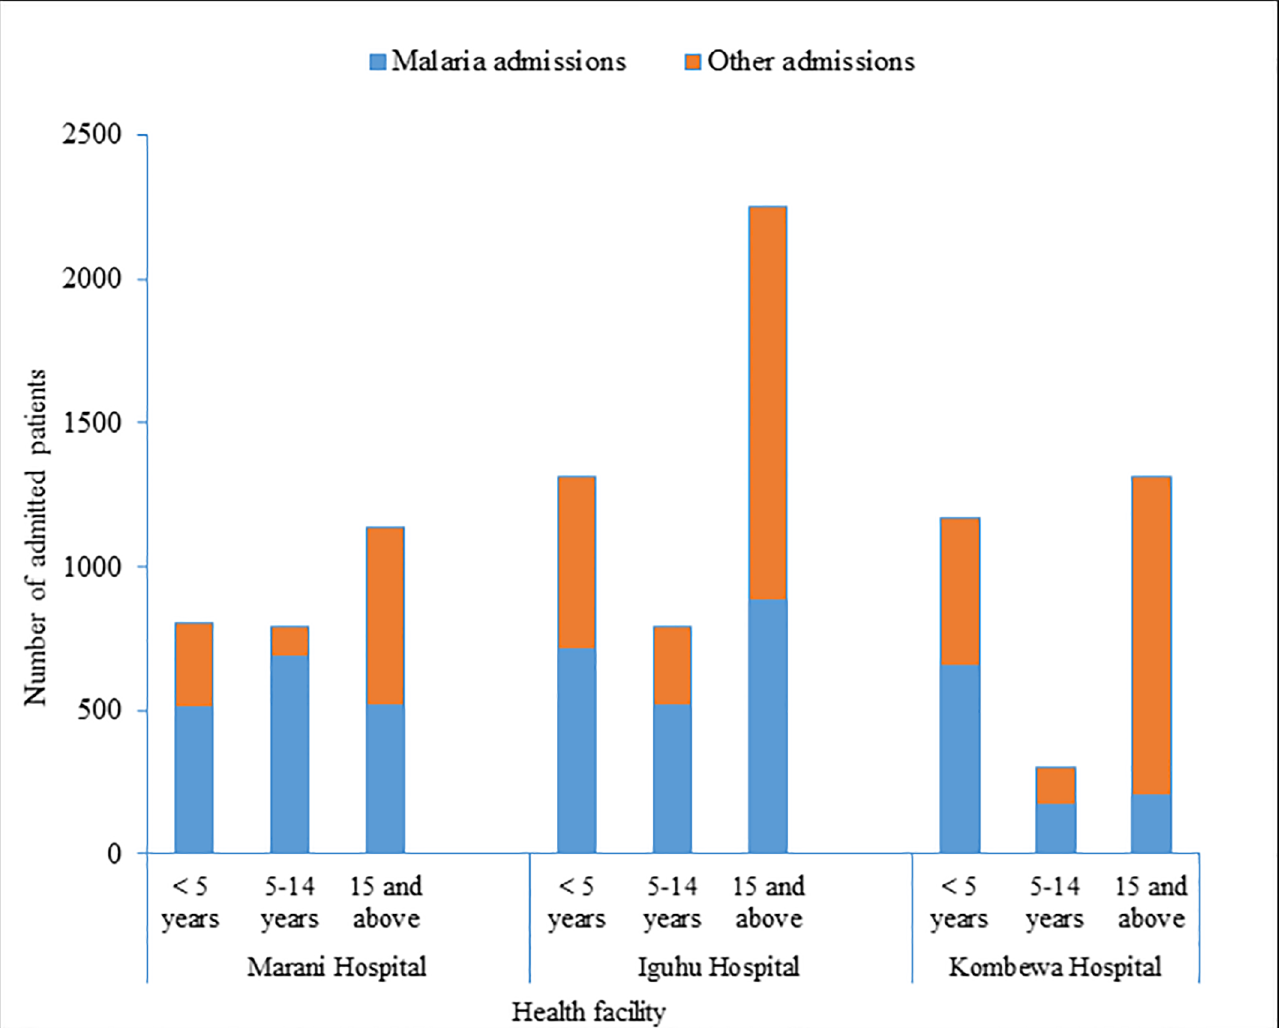
Fig 4. Malaria admissions and total number of admissions hospitals located in three areas with malaria transmission intensity and interventions responses in Western Kenya from June 2015 to August